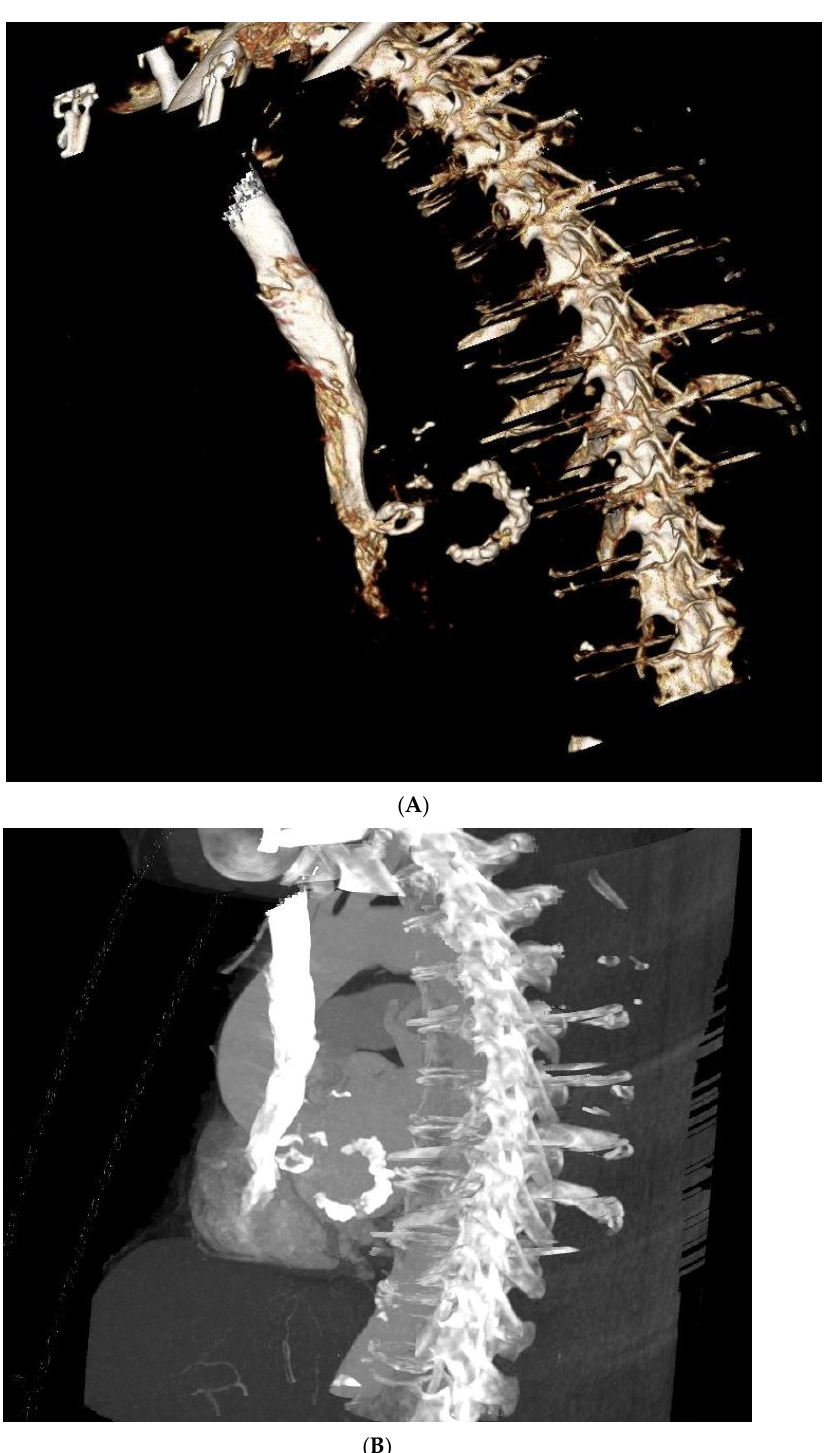
Figure 1. Computed Tomography showing extensive mitral annular calcification. ( A ) 3D recontruc- tion of the calcified mitral annulus. ( B ) Computer tomography of the calcified mitral annulus.